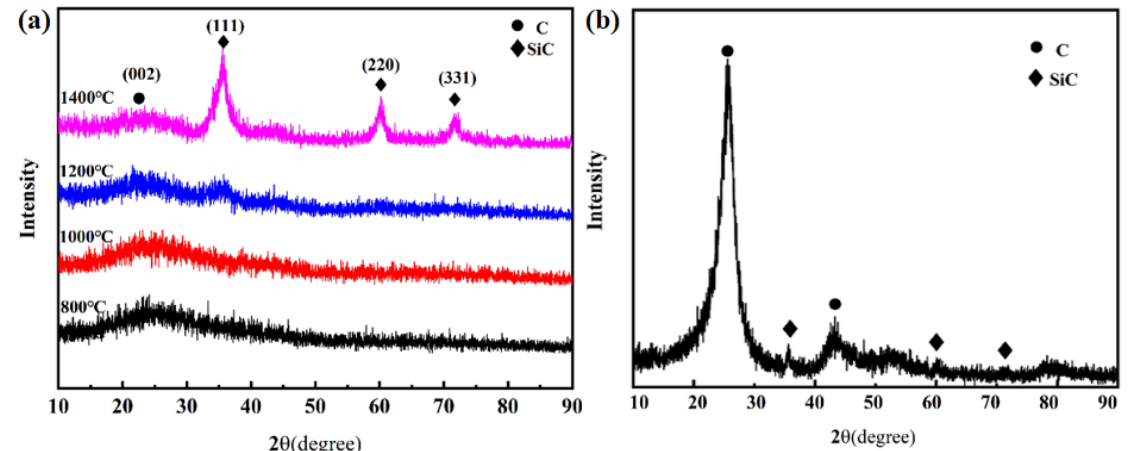
Figure 4. XRD pattern of samples: ( a ) the pyrolysis products of PSA at different heat-treatment temperatures; ( b ) the Cf/C-SiC composite after hot pressing at 1400 °C.